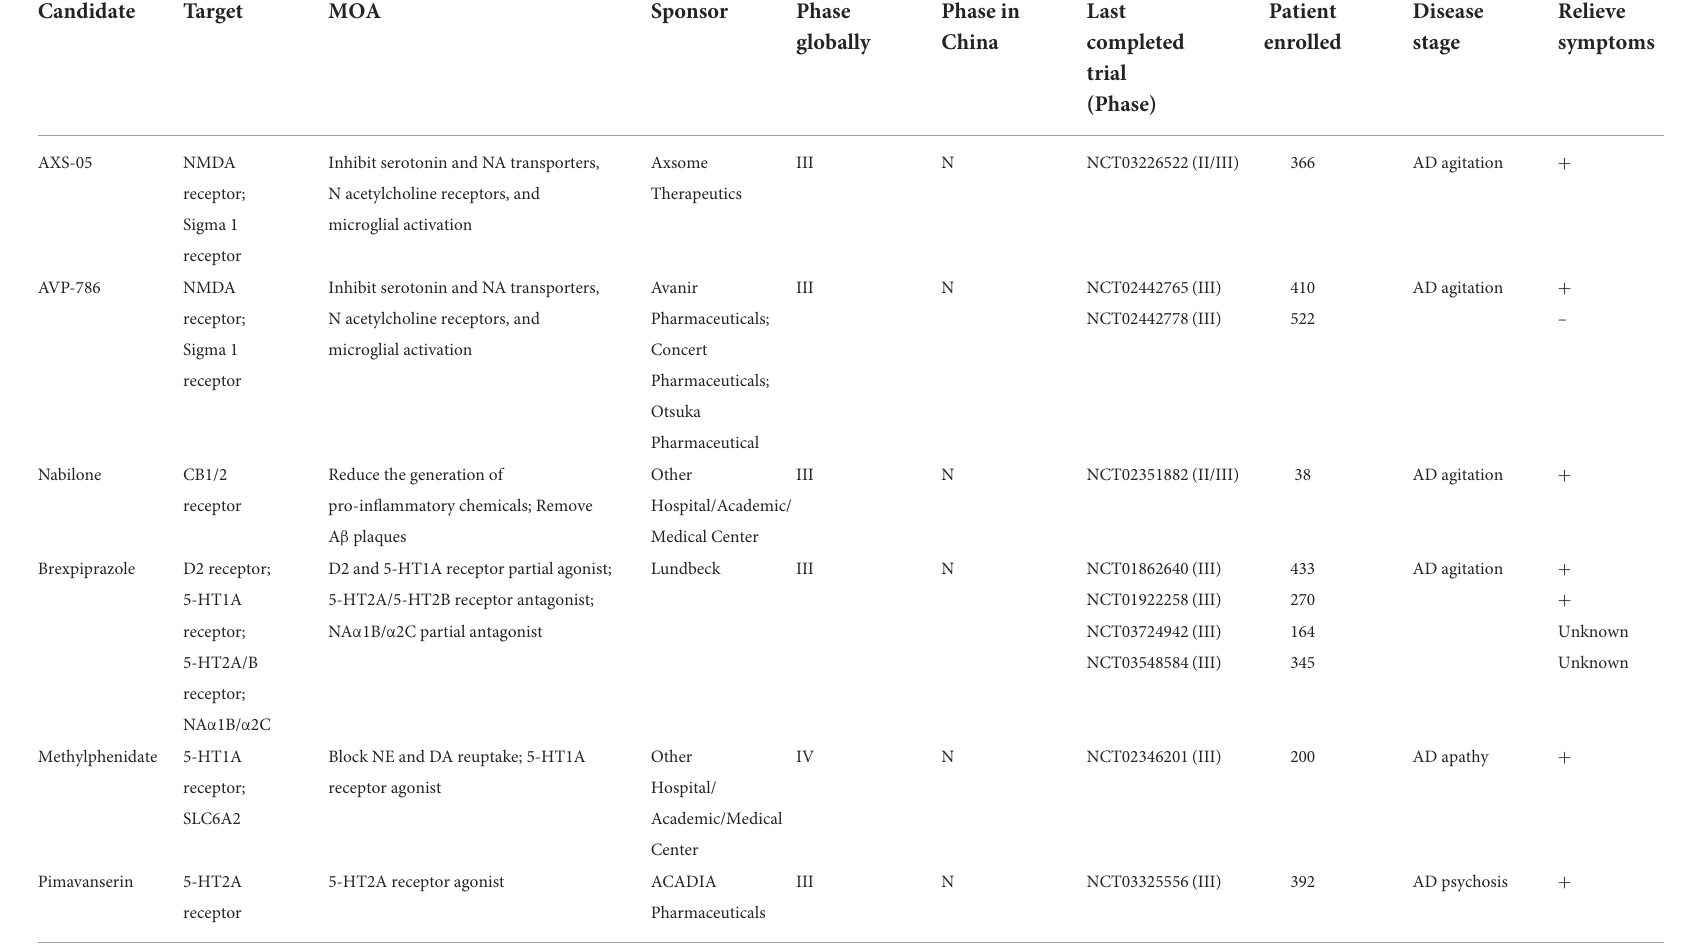
TABLE 2 Symptomatic therapy in active development from 2017 to